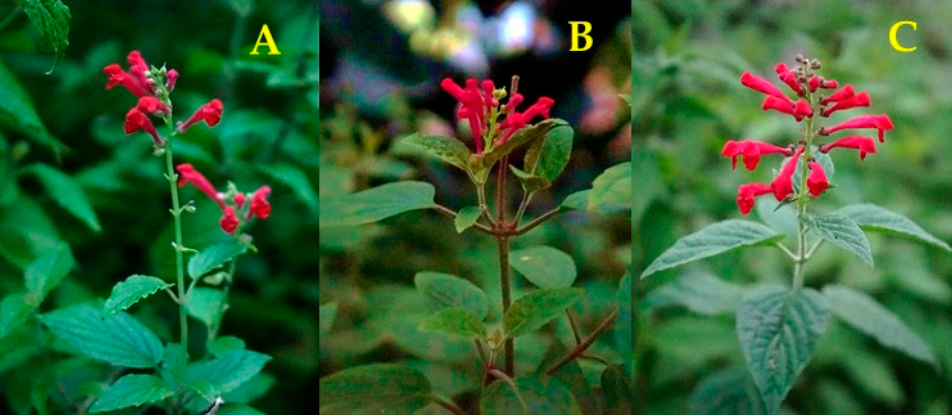
Figure 1. Scutellaria plants native to Colombia at their flowering stage: ( A ). S. incarnata ; ( B ). S. coccinea ( C ). S. ventenatii × S. incarnata .